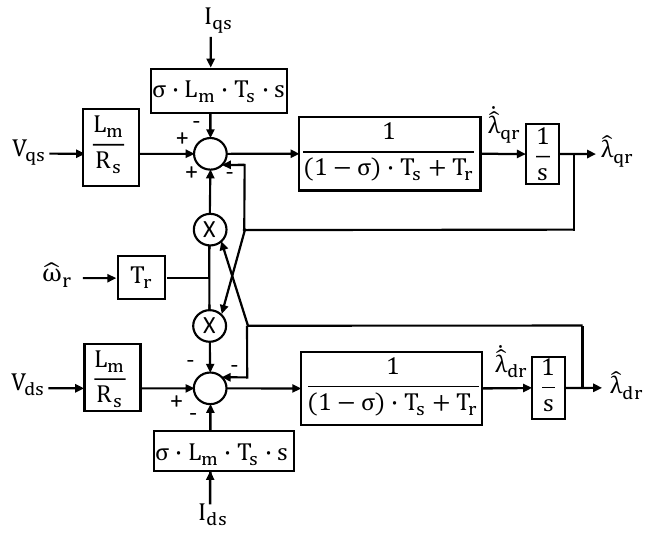
Figure 4. Block diagram of the rotor flux linkage observer (build from [35]).